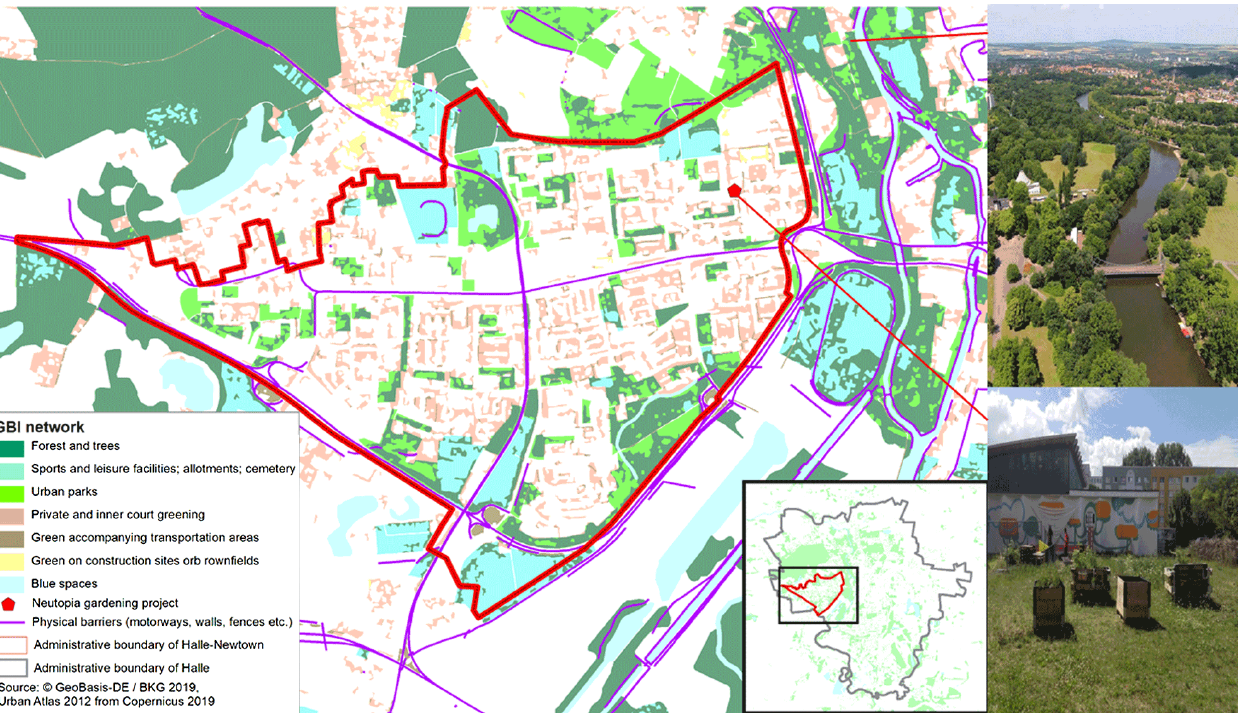
Fig. 2 . In its upper section, this figure shows the green-blue infrastructure (GBI) network of Halle, in particular, the central Saale floodplains and Halle-Newtown in the west including the Neutopia community garden with its planting boxes. The pink lines stand for strong physical barriers (roads, tram rails) and the river Saale. The pictures on the right provide an impression of the shape of the GBI in the Saale floodplains and Halle-Newtown (Figure by Manuel